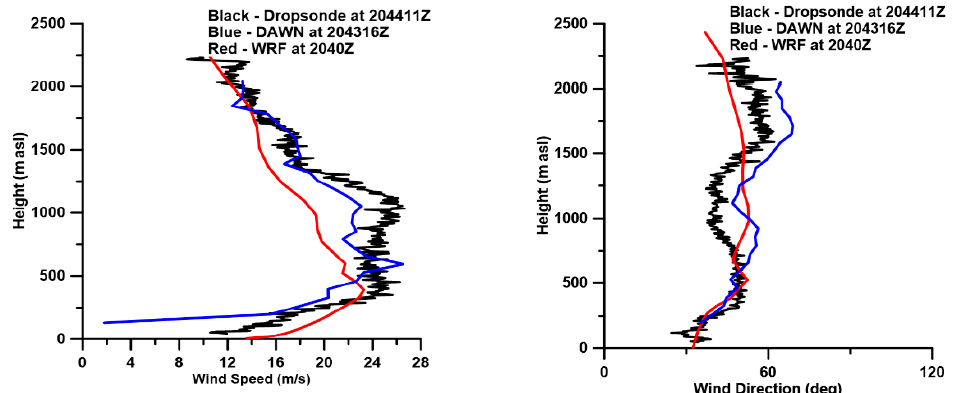
Figure 11. DAWN, dropsonde and model profiles of wind speed ( left ) and wind direction ( right ) further off-shore around 2041Z on 21 May 2015.